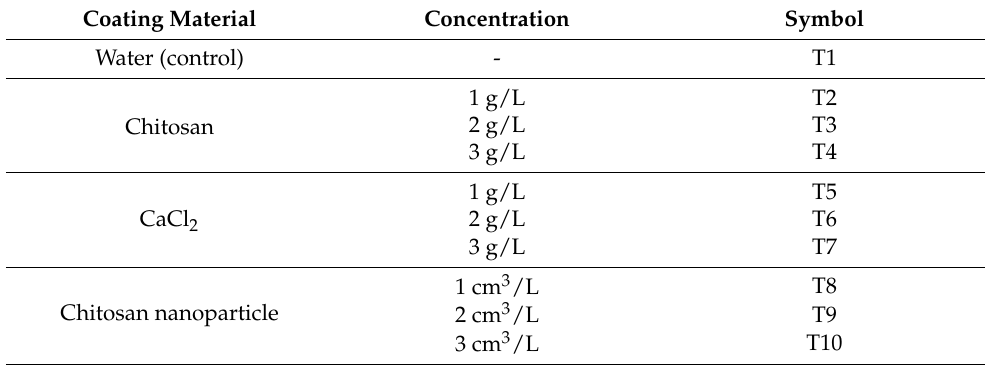
Table 1. Pre-harvest treatments of Barhi